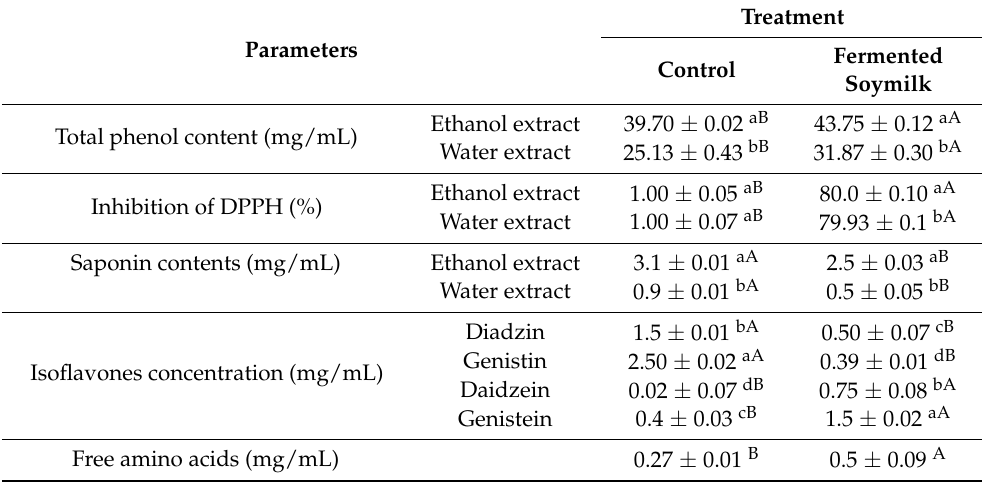
Table 2. The soymilk fermented probiotic bacterial strains contain total phenolic, antioxidant, agly- cone isoflavones, free amino acids, and